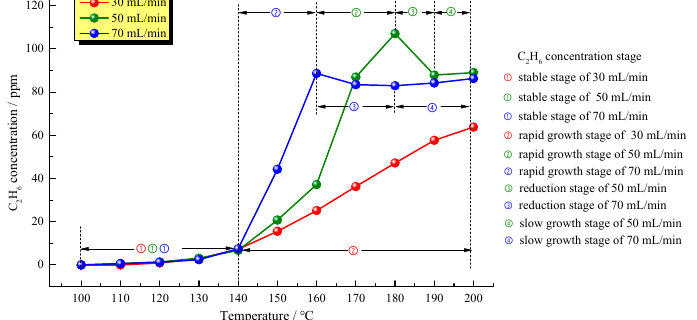
Figure 5. Relationship between the C 2 H 6 concentration and temperature at different air supply rates.